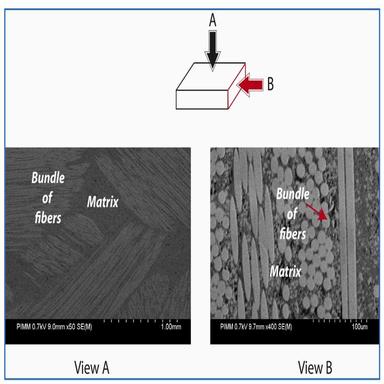
Microstructure observation of RO-A-SMC composite.